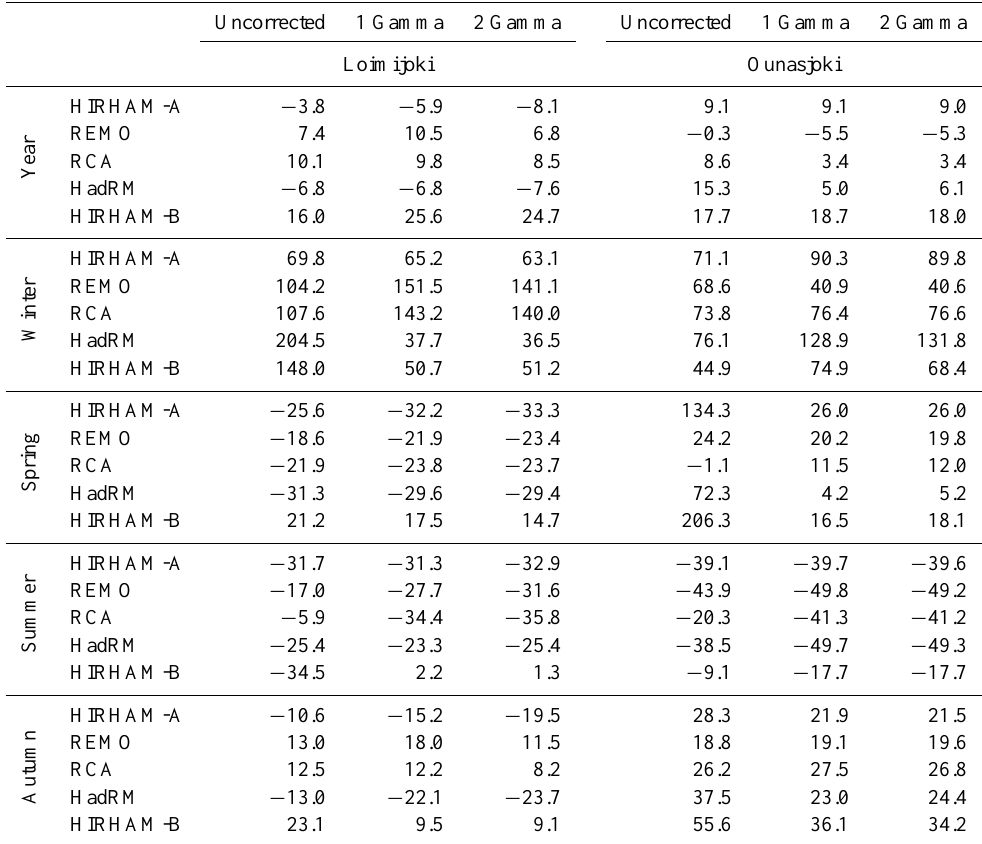
Table 6. Relative changes (%) in simulated annual and seasonal mean discharges (MQ) in Loimijoki and Ounasjoki between control period 1961–2000 and future period 2051–2090 using uncorrected and DBS-adjusted temperature (Gaussian) and precipitation (1 or 2